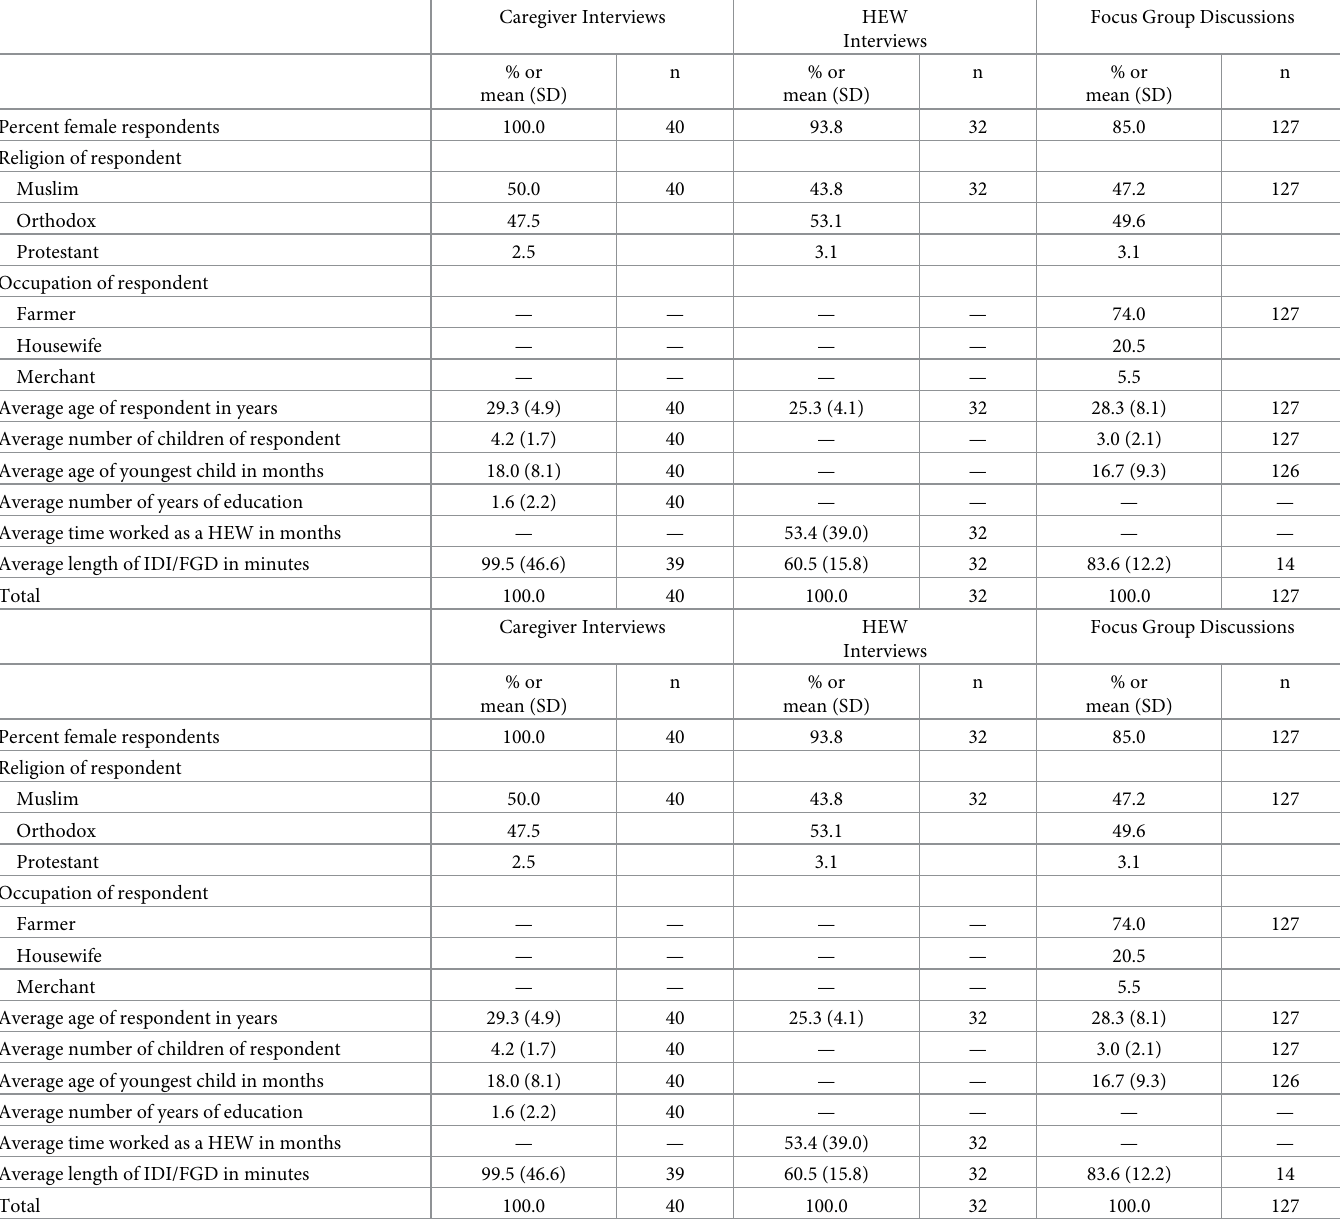
Table 1. Sociodemographic characteristics of the IDI and FGD participants from four regions of Ethiopia, 2018 (n = 199). Caregiver